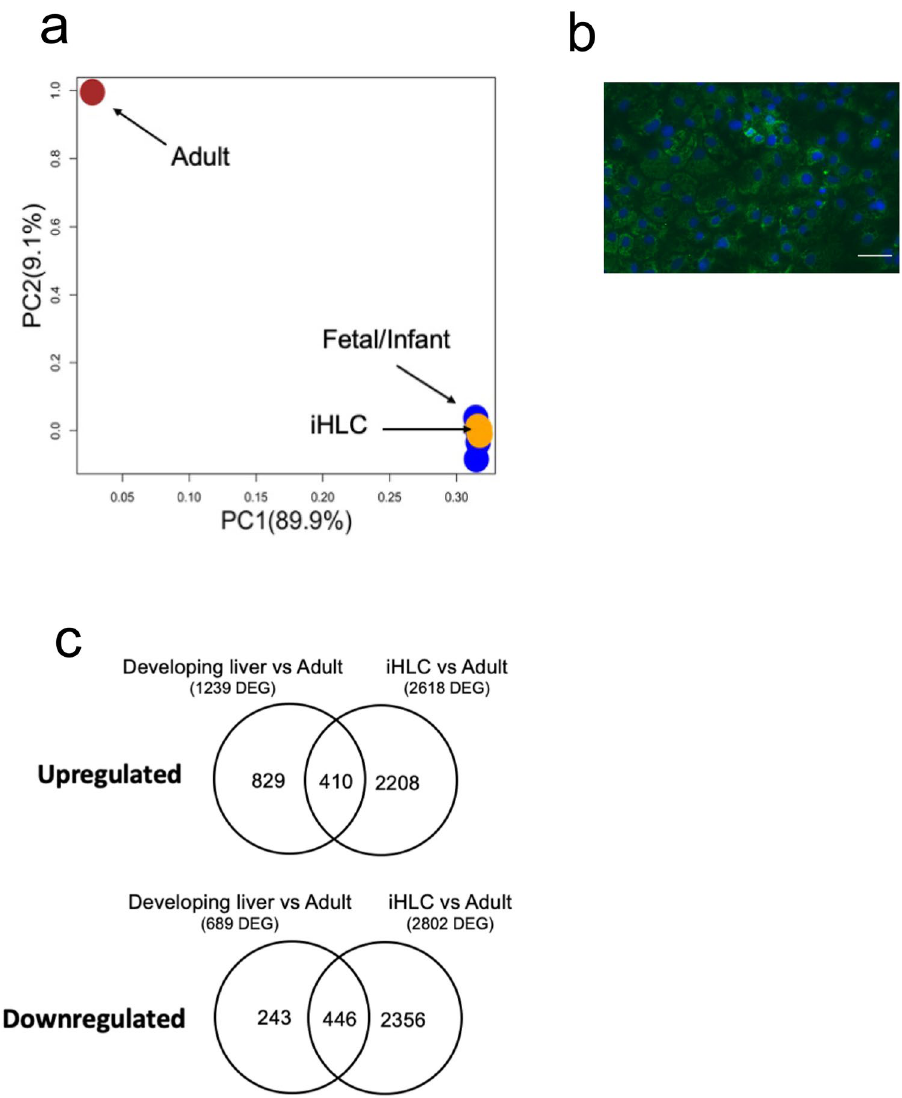
Figure 1. Transcriptome differences in human developing liver, iHLC, and adult liver. ( a ) Principle component analysis (PCA) plot showing variance in gene expression among iHLC from 6 independent differentiations (yellow), 4 human fetal/infant liver samples (blue), and adult liver (red). The top 2 components (PC1 and PC2) account for 99% of the variance among samples, and the variance captured within each coordinate is shown in parentheses. ( b ) Immunocytochemistry of fully differentiated iHLC showing cytoplasmic presence of alpha- fetoprotein (AFP). Scale bar: 25 μm. ( c ) Venn diagram summarizing the overlap of differentially expressed genes (DEG) that are upregulated and downregulated between developing liver vs adult liver compared with DEG in iHLC vs adult liver. DEG were genes with fold change ≥ 4 and adjusted p -value < 0.05 in each